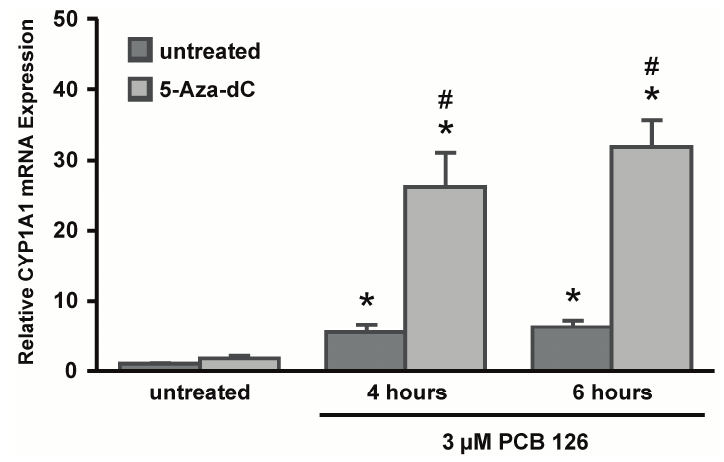
Figure 3. Increased expression of CYP1A1 mRNA triggered by 5-aza-2'-deoxycytidine (5-Aza-dC). HeLa cells were either left untreated or treated with 5-Aza-dC for seven days, and subsequently treated with 3 µM PCB 126 for 4 or 6 h. qRT-PCR was used to assess CYP1A1 mRNA expression with normalization to RPLP0 mRNA. * p < 0.05 vs. control; # no drug treatment vs. 5-Aza-dC treatment; Error bars = SEM; n =